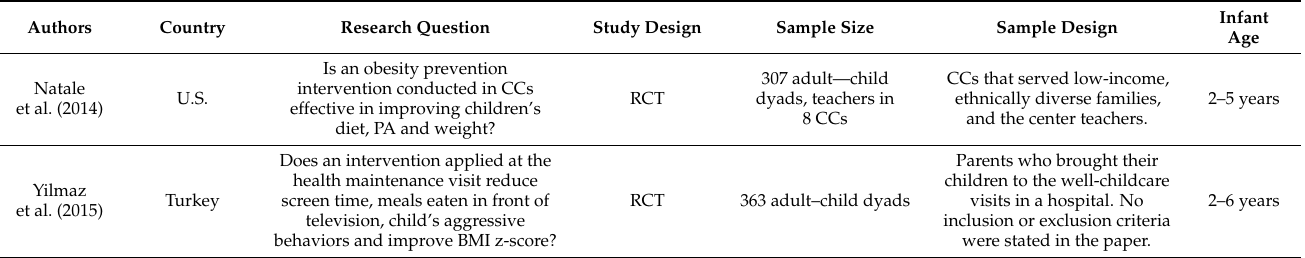
Table 2. Summary of studies evaluating obesity prevention interventions among children between 0 and three years that included non-parental